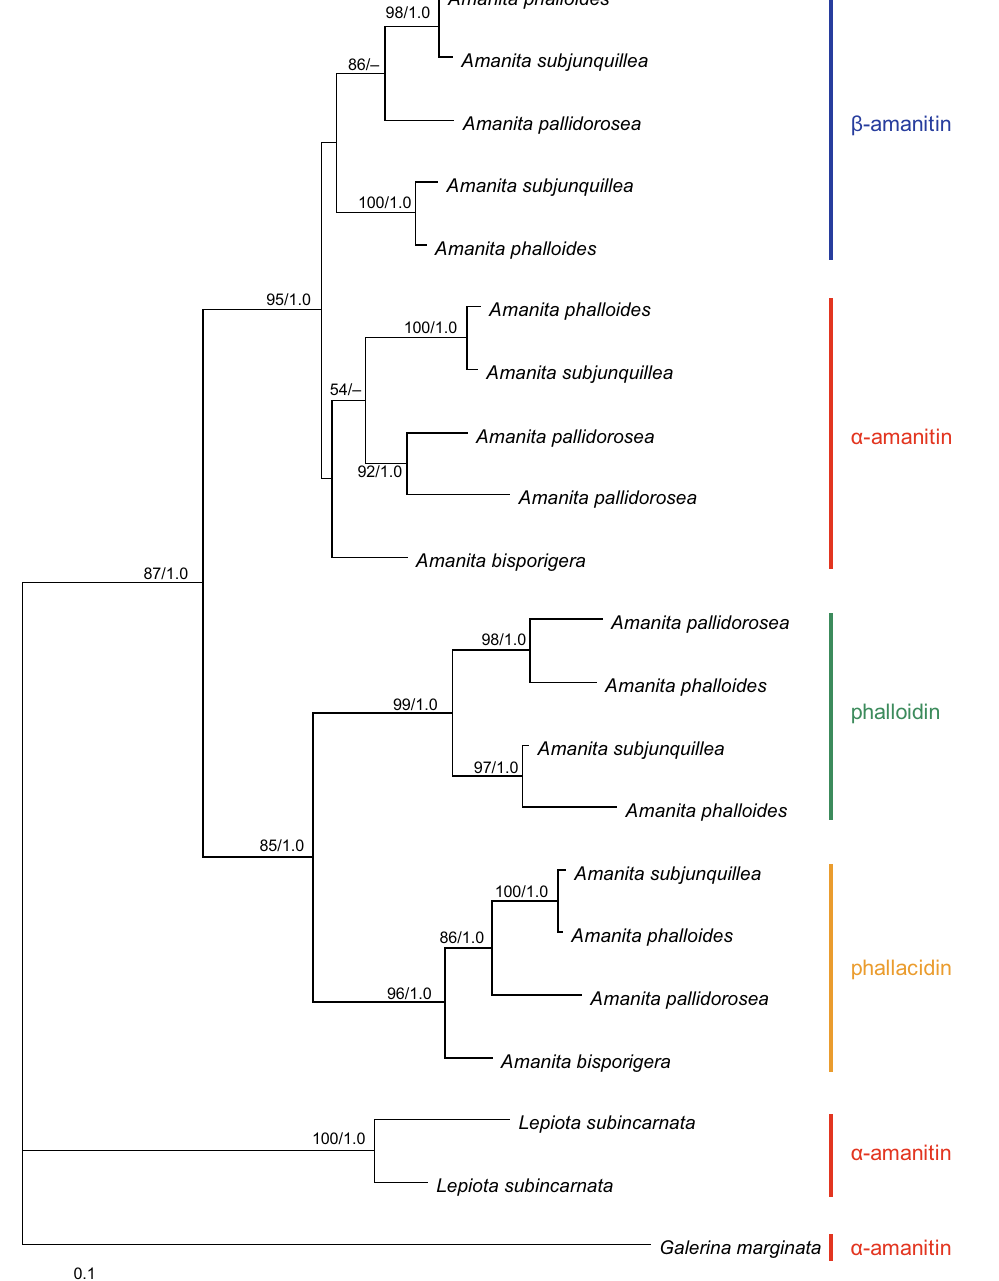
Fig. 5. Phylogeny of MSDIN genes in Amanita, Galerina and Lepiota inferred from maximum likelihood (ML). Maximum likelihood